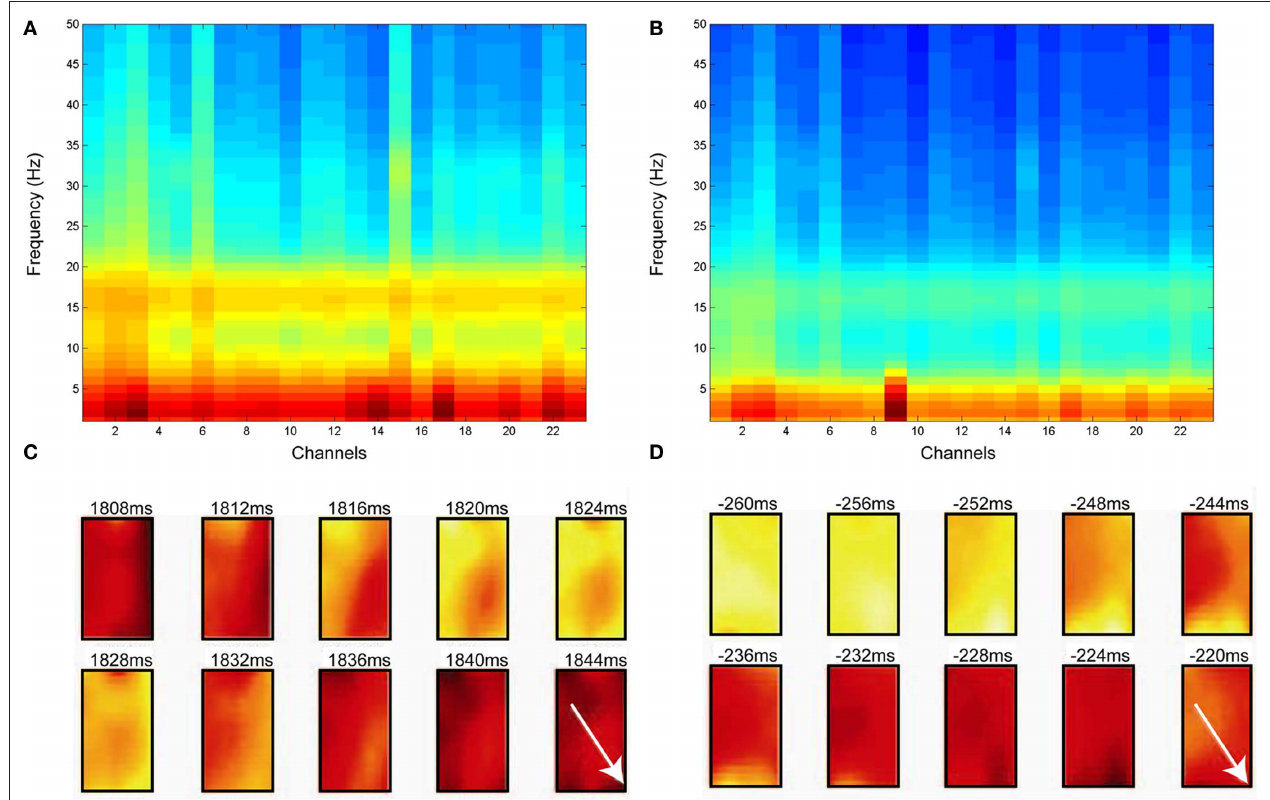
during the Engaged condition (C) and the Resting condition (D) . Each snap shot is 6 ms apart and time progresses from the upper left to lower right measured with respect to a cue timing and the beginning of a Resting condition for (C,D) respectively. The white arrow in both figures shows the wave